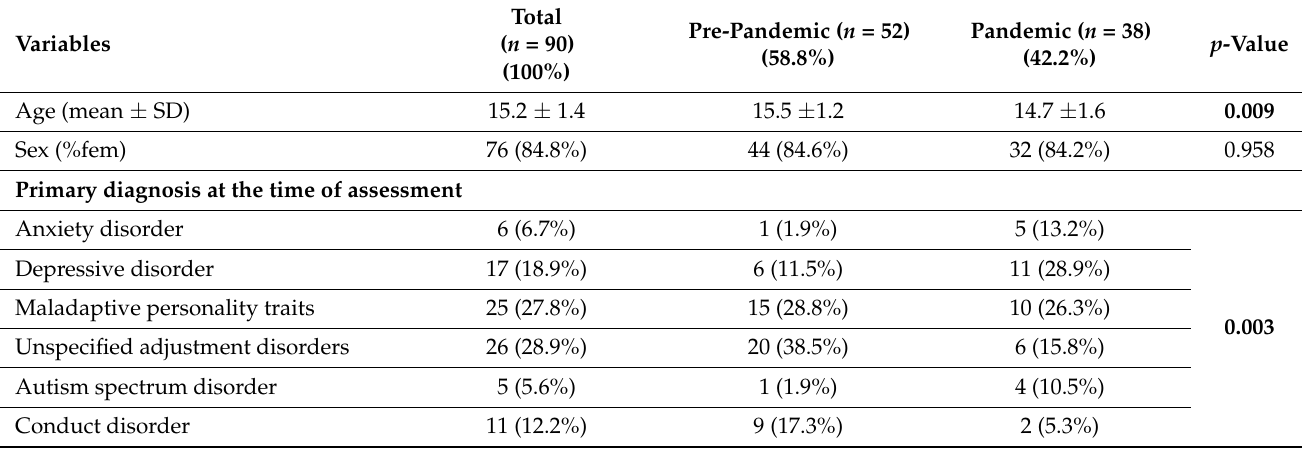
Table 1. Demographics and clinical variables of the participating adolescents with a suicide attempt, divided via the two study periods (pre-pandemic from February 2019 to February 2020 and pan- demic form March 2020 to March 2021). SD = Standard deviation; ADHD = Attention Deficit and Hyperactivity Disorder; SIS = Suicidal Intent